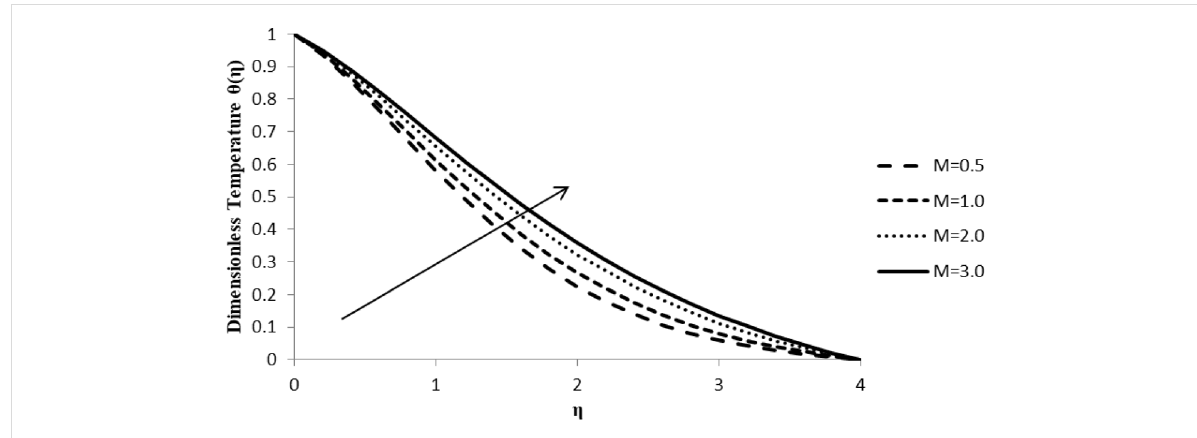
Figure 13: Influence of the magnetic parameter M on the temperature distribution θ ( η ) when n = 2.0, Pr = 2.0, Nb = Nt = 0.5, Q = 0.0, Le = 5.0, ξ = 1.0, and F w = 0.2.